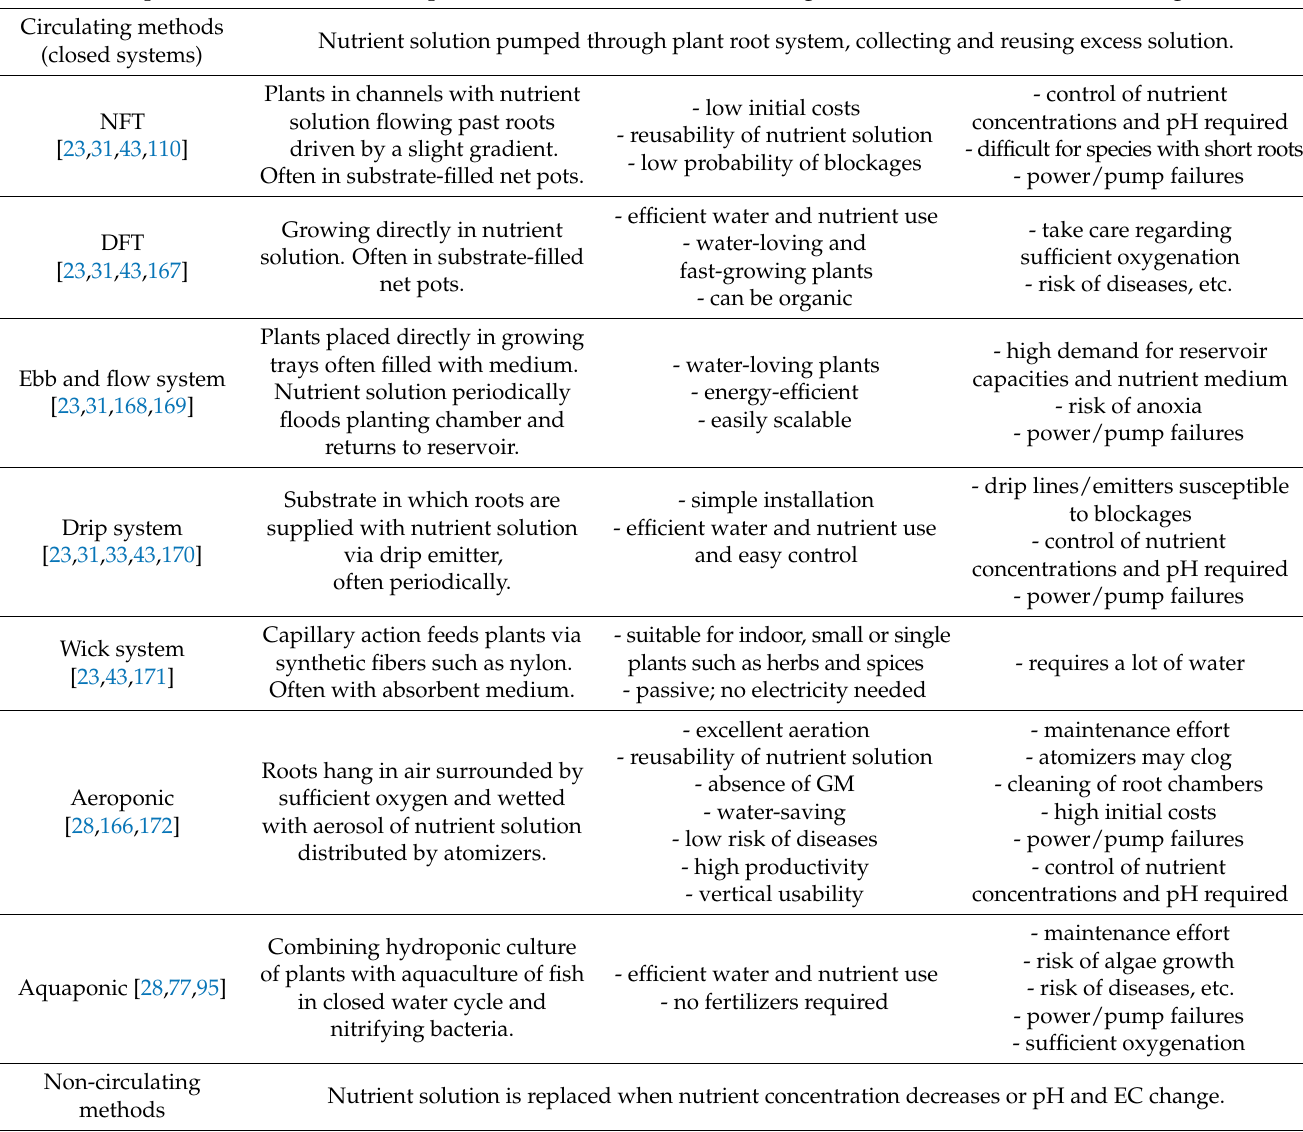
Table A1. Liquid or solution culture techniques further subdivided into circulating (closed)